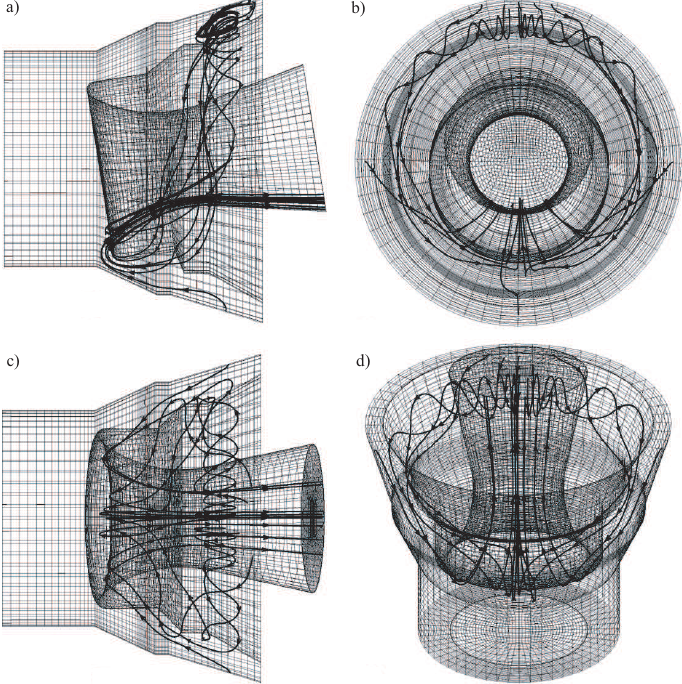
Figure 19. Streamlines near the rear nozzle head for cylindrical channel ( α = 9 ◦ ): view in xy plane ( a ), view in yz plane ( b ), view in xz plane ( c ), three-dimensional view ( d